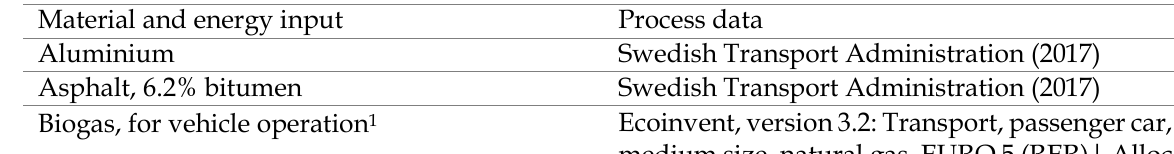
Table A12. Process data used to quantify GHG emissions and energy use of material and energy production. Table continues on the next